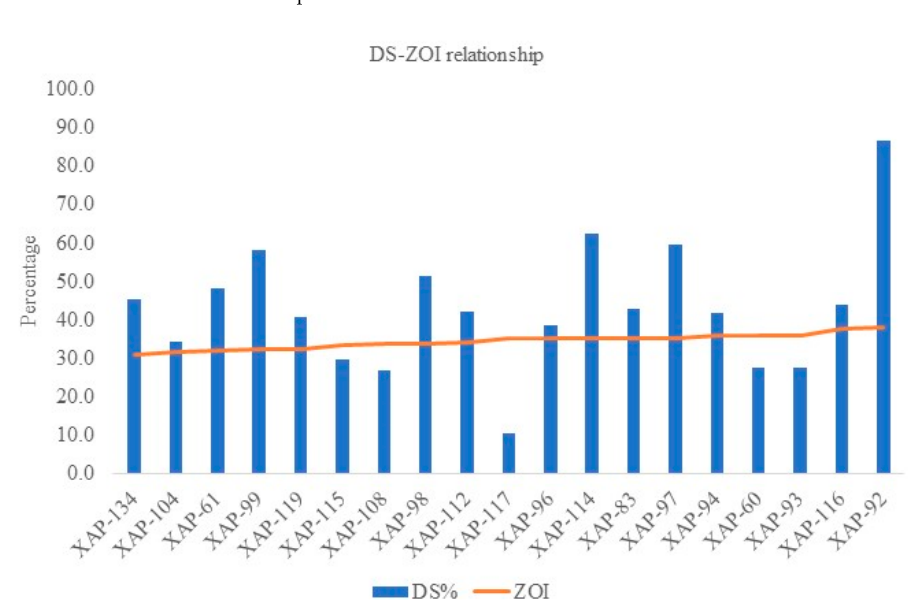
Figure 4. Relationship between percent disease severity (% DS) observed after 6 weeks and zone of inhibition (ZOI) at the highest concentration (1500 µg/mL).